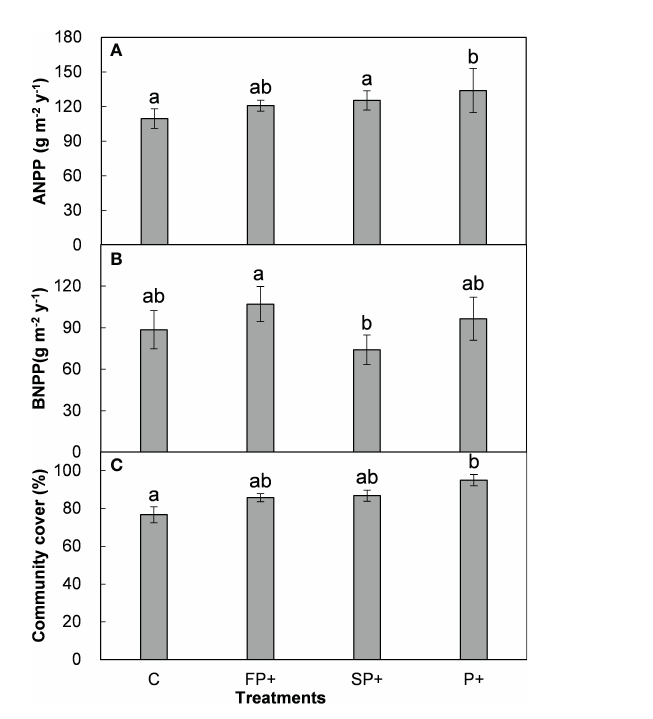
FIGURE 3 Aboveground net primary production (ANPP, A ) and belowground net primary production (BNPP, B ), and plant community cover (C) in response to increasing fi rst half and/or second half of growing-season precipitation.